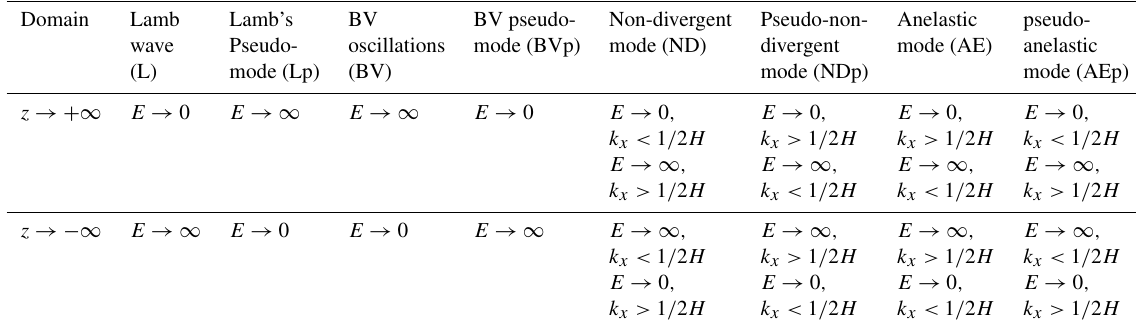
Table 3. The change in energy density of evanescent modes with height in an infinite isothermal atmosphere. Domain Lamb Lamb’s BV BV pseudo- Non-divergent Pseudo-non- Anelastic pseudo- wave Pseudo- oscillations mode (BVp) mode (ND) divergent mode (AE) anelastic mode